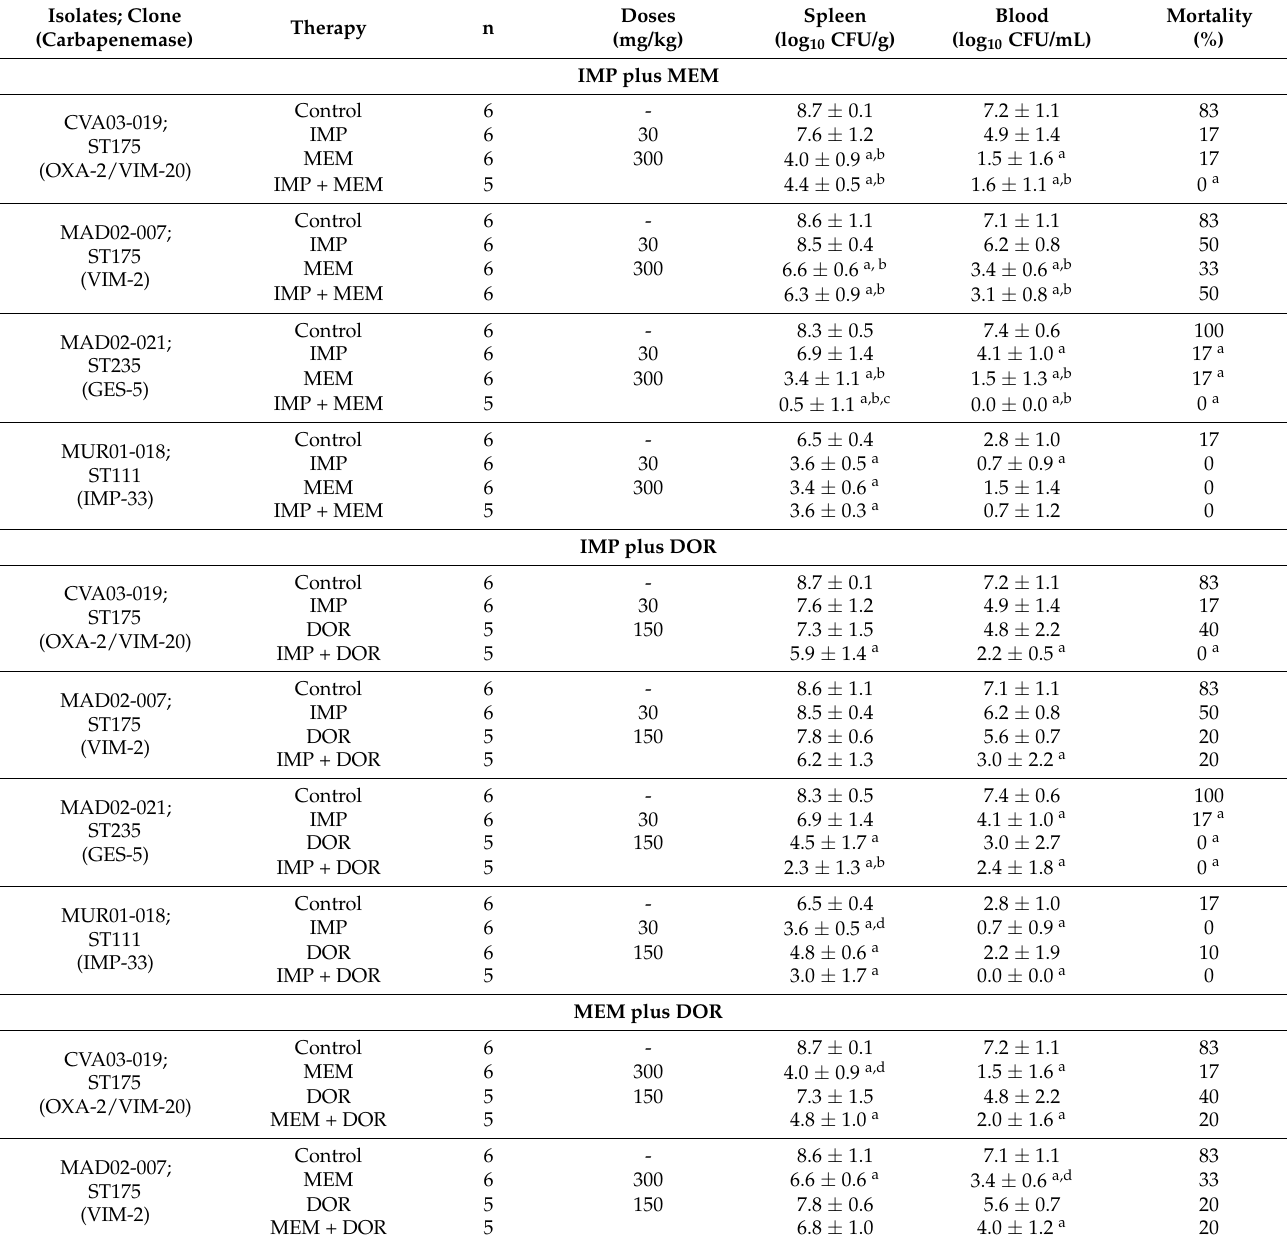
Table 3. In vivo efficacy of imipenem, meropenem, and doripenem, in monotherapy and in combina- tions, for the experimental peritoneal sepsis